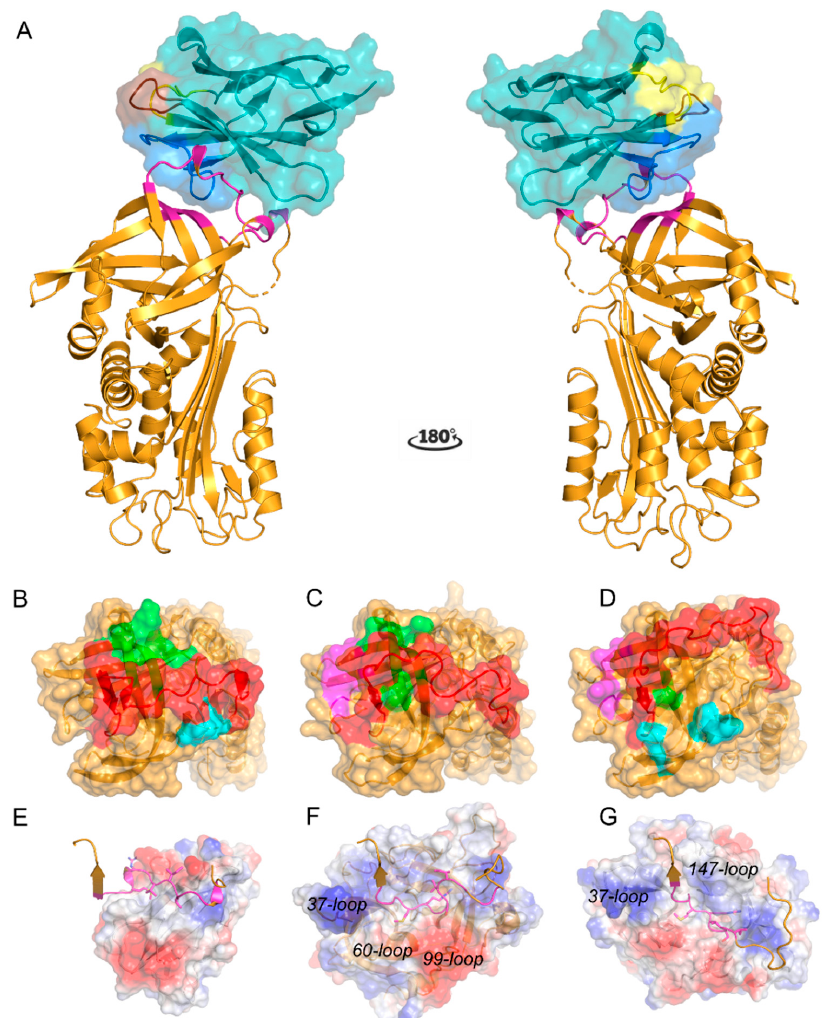
Figure 1. Crystal structure of the PAI-1/Nb93 complex. ( A ) Cartoon representation of the crystal structure of PAI-1 (orange) complexed with Nb93 (teal). Residues 331 and 332 of the reactive center loop (RCL) were not observed in the crystal structure and are presented by a dashed line. Together with the cartoon representation, the biological surface of Nb93 is represented. Framework regions of Nb93 are colored cyan and teal; the complementarity-determining regions (CDR) 1, CDR2, and CDR3 are in yellow, brown, and blue, respectively. The residues in PAI-1 closer than 4 Å to Nb93 are in magenta; ( B ) Surface representation of the top of the PAI-1 molecule with the indicated contact regions (residues closer than 4 Å) for Nb93. Nb93 binds to the RCL in red and has adjacent contact regions in green (Thr205, Lys207, and Pro270) and cyan (Asp181 and Ser182); ( C ), Surface representation of the top of the PAI-1 molecule with the indicated contact regions (residues closer than 4 Å) for tissue-type plasminogen activator (tPA). The RCL is in red, the exosite region for the 37-loop of tPA is in magenta (Tyr210, Glu212, Asp222, andTyr241) and the contact regions adjacent to the RCL are in green (Thr205, Lys207, and 269-Leu-Pro-Arg-Leu-272); ( D ) Surface representation of the top of the PAI-1 molecule with the indicated contact regions (residues closer than 4 Å) for urokinase-type plasminogen activator (uPA). The RCL is in red, the exosite region for the 37-loop of uPA is in magenta and the contact regions adjacent to the RCL are in green (Leu272) and cyan (Ser182, Ser183, and Arg187); ( E–G ) Cartoon representation of the bound RCL and the charged surface representation of Nb93 ( E ), tPA ( F ), and uPA ( G ), respectively. Exosite loops of tPA and uPA are indicated.